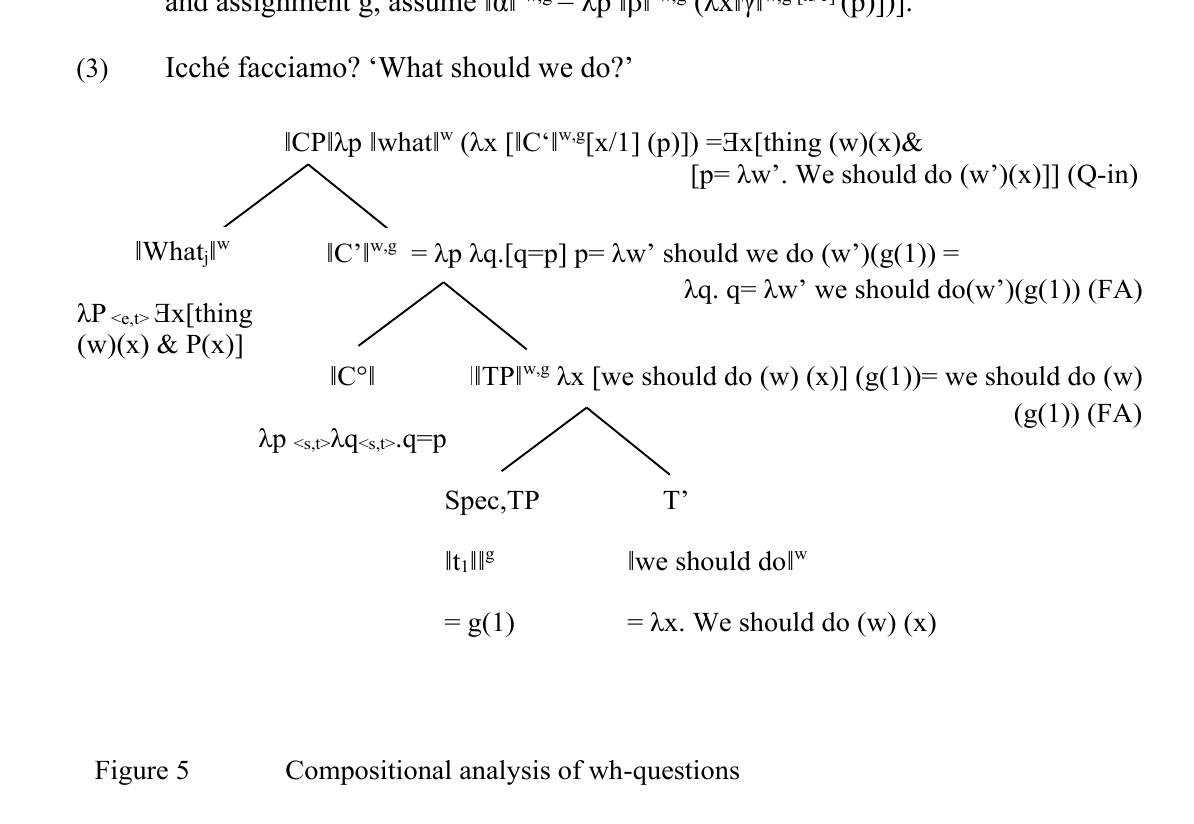
Figure 5 Compositional analysis of